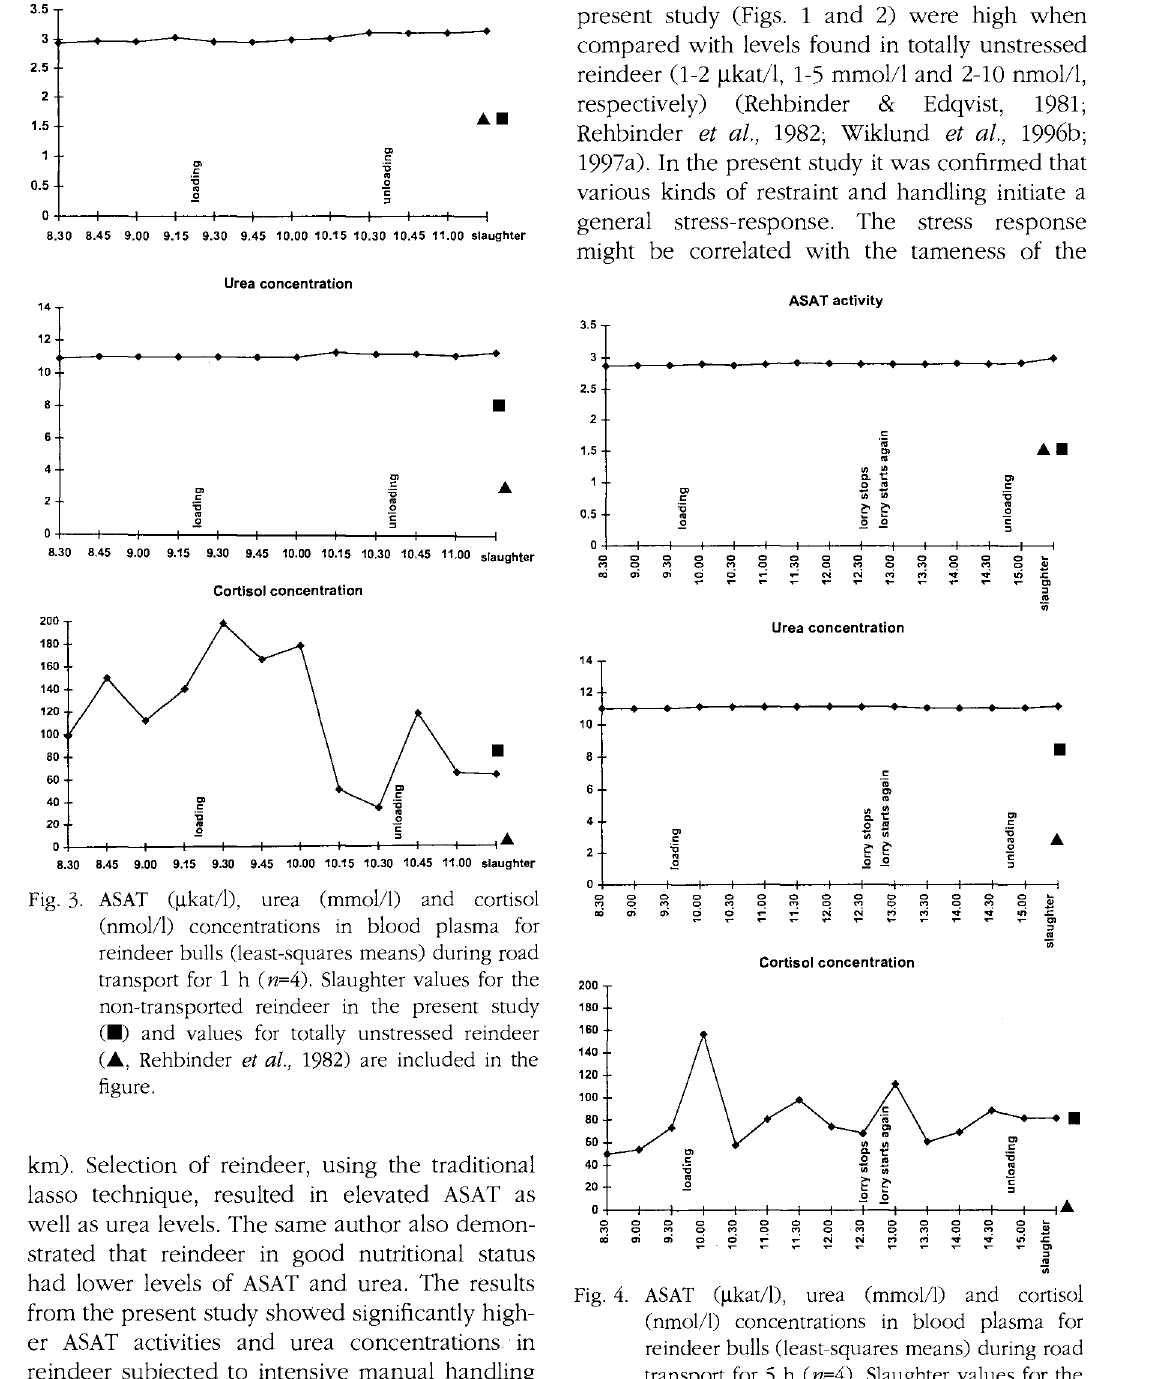
Fig. 3. ASAT Cu-kat/l). urea (mmol/l) and Cortisol (nmol/l) concentrations in blood plasma for reindeer bulls (least-squares means) during road transport for 1 h (w=4). Slaughter values for the non-transported reindeer in the present study (•) and values for totally unstressed reindeer (A, Rehbinder et al., 1982) are included in the figure.